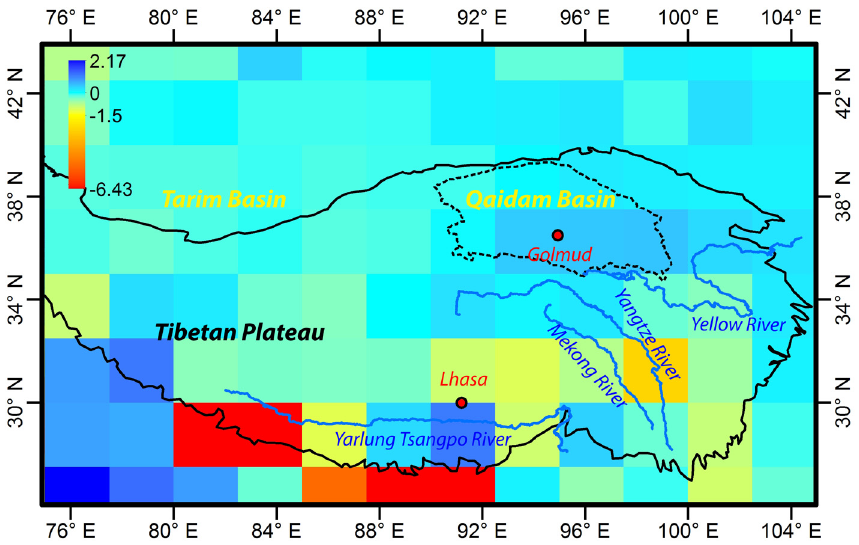
Fig 5. Spatial distribution of changes in precipitation (mm/month) in the TP and surrounding regions from 2003 to 2012 calculated by